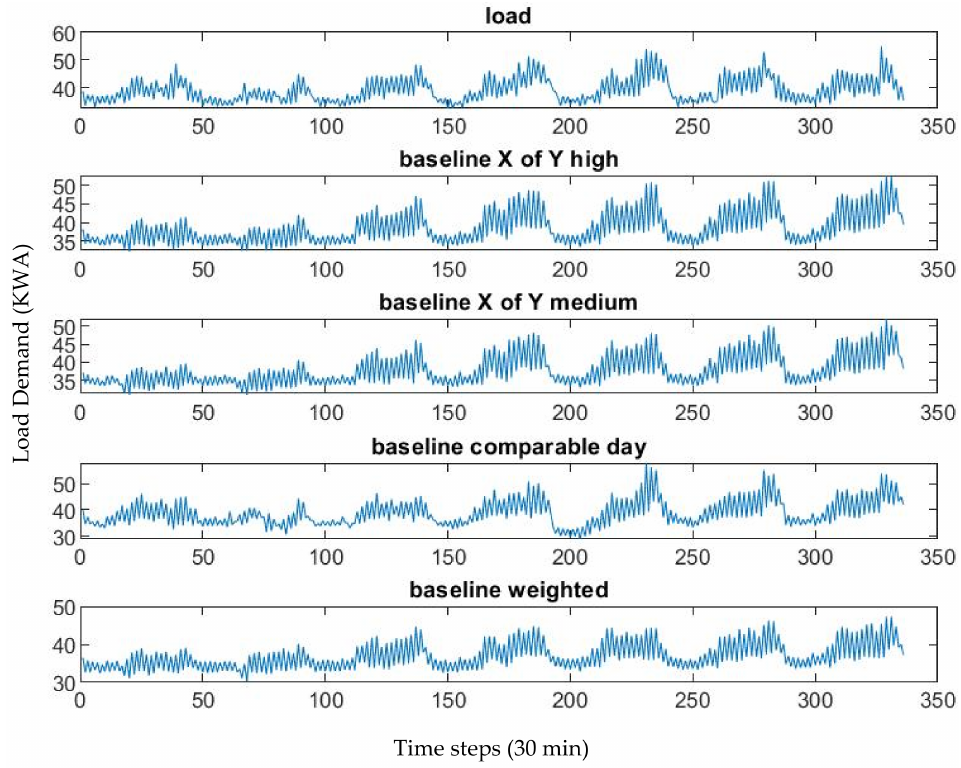
Figure 2. Reactive power baseline building